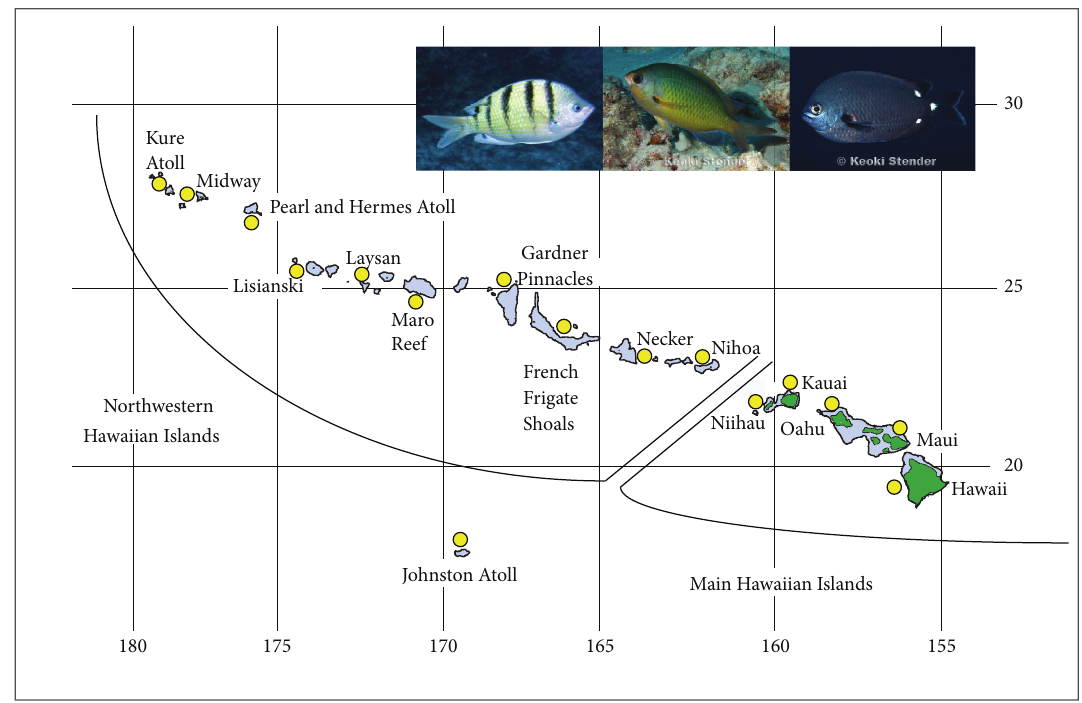
Figure 1: Map of collection locations in the Hawaiian Archipelago and Johnston Atoll for A. abdominalis , C. ovalis , and C. verater (photos left to right). Specimens of all species were collected at each location with the exception of Maro Reef and Johnston Atoll. No C. verater specimens were collected at Maro Reef, and only C. verater specimens were collected at Johnston Atoll. Yellow dots indicate collection locations, green indicates high islands, and blue indicates low islands and shallow habitat. (Photo credit for A. abdominalis : Kim Tenggardjaja. Photo credit for Chromis species: Keoki Stender,